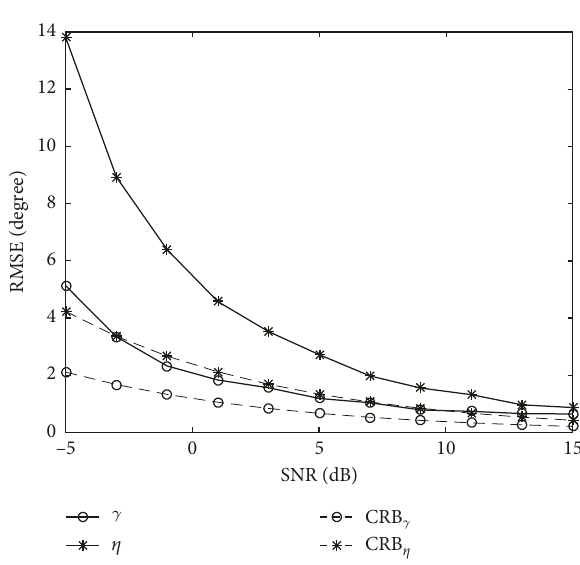
Figure 8: Polarization parameters estimation performances with different SNR.